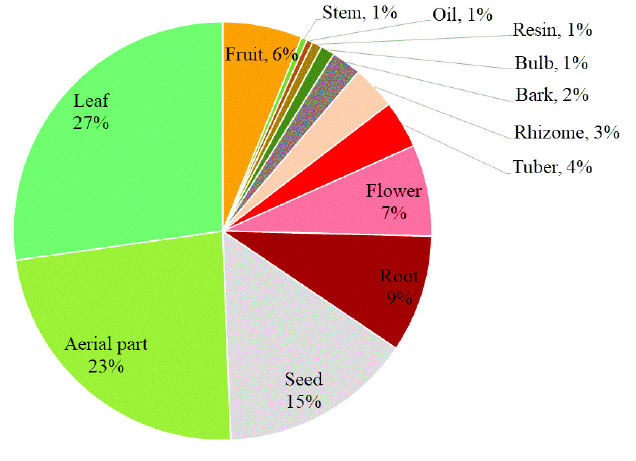
Figure 3. Plant parts used and their frequency.